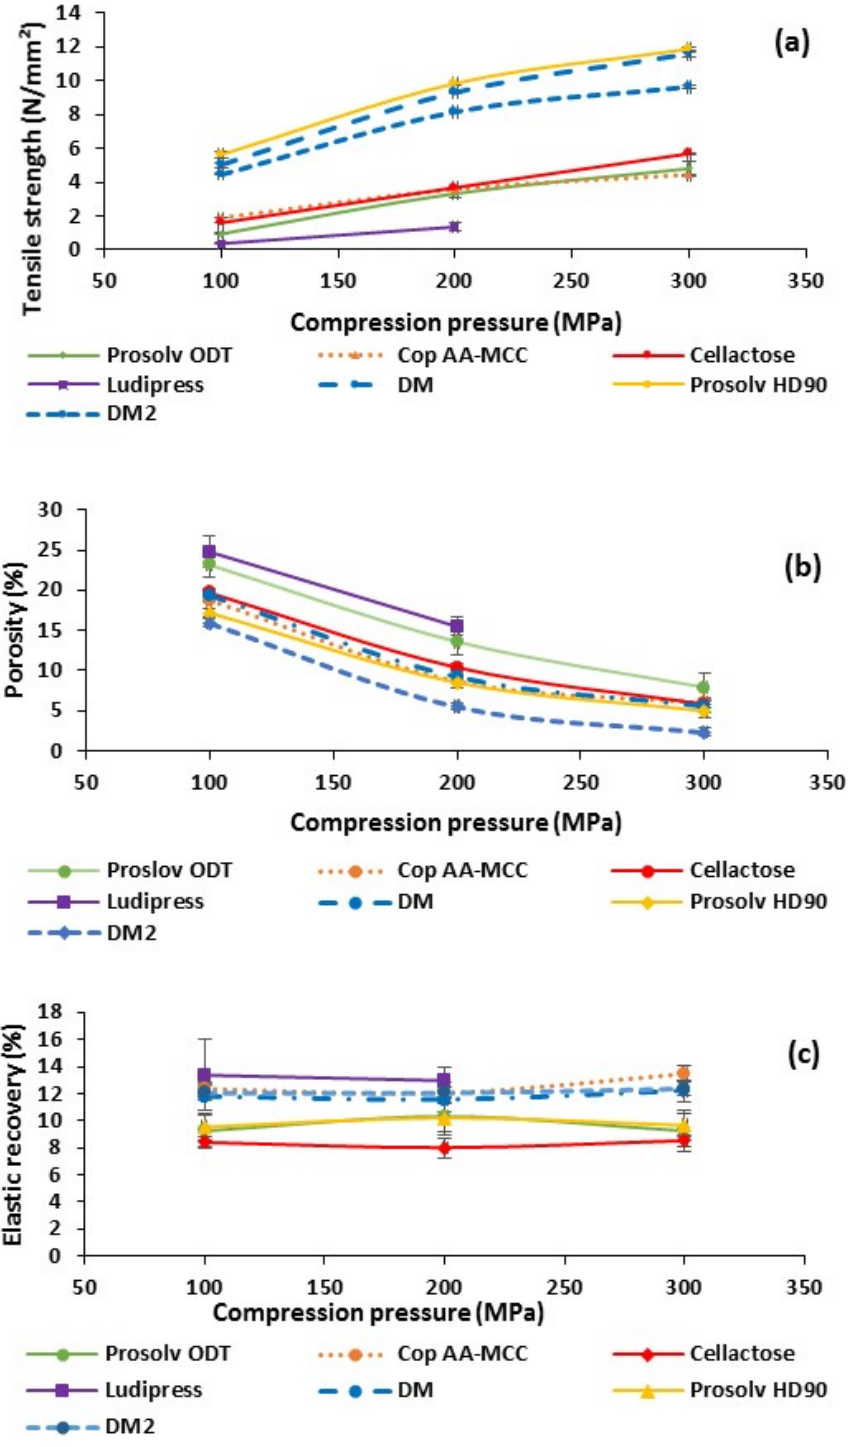
Figure 2. Tablets’ tensile strength ( a ), porosity ( b ), and elastic recovery ( c ) as function of compression pressure of all the non-lubricated tested materials.